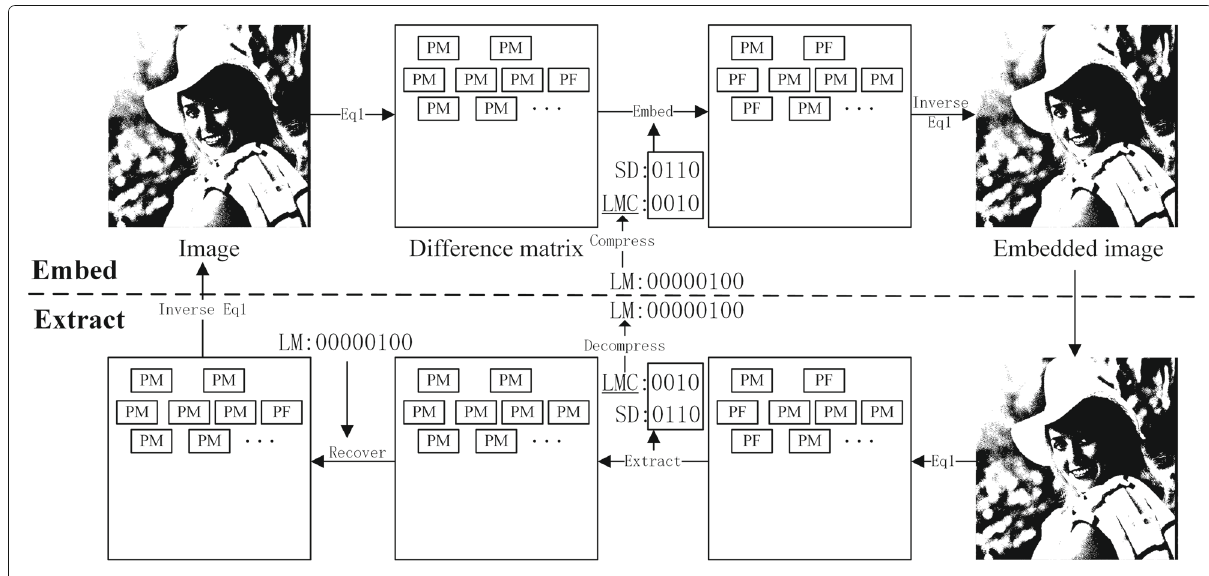
Fig. 4 An example of PS embedding